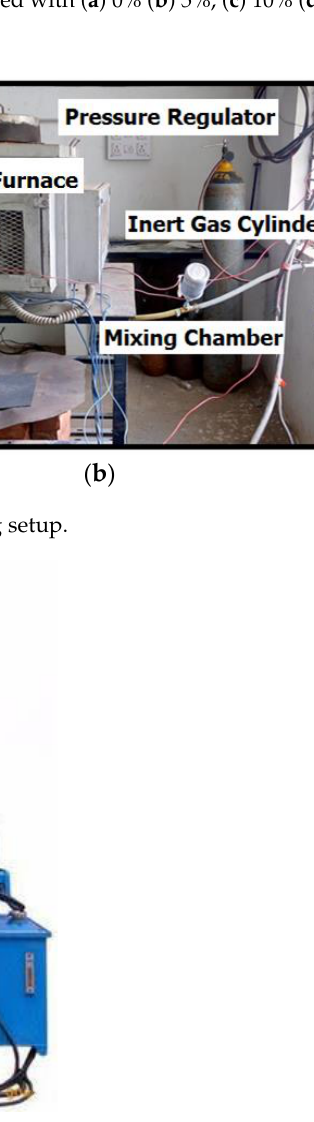
Figure 5. Tensile test samples. The Taguchi’s design of experiments method is the statistical tool used to optimize the processing conditions by formulating the experimental layout by using the software known as MINITAB 15 [18–23].The S / N ratio characteristic (the larger the better) is given in Equation (1). (1) where n is the number of observations and y is the observed data. In the present work, Taguchi L 32 orthogonal array is employed to identify the optimal processing conditions. The factors and levels chosen for the experiments are summarized in Table 2.